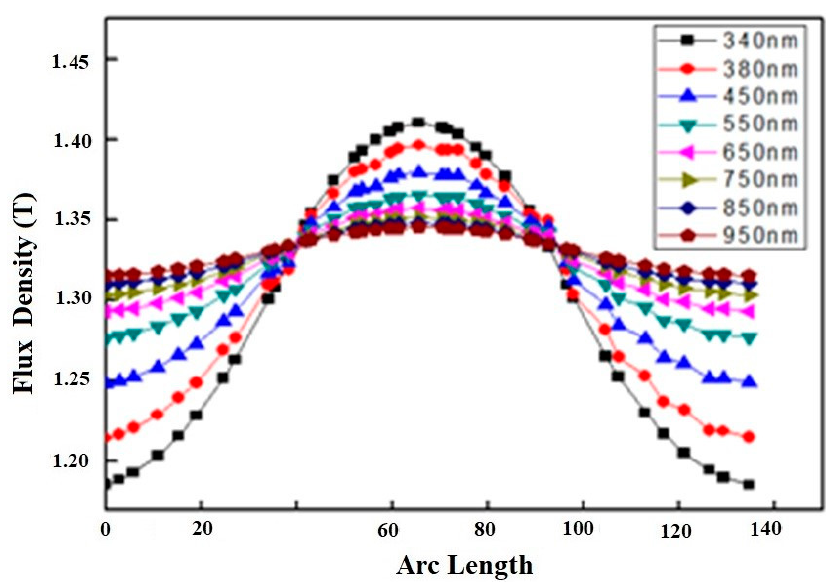
Figure 2. Flux density versus arc length showing propagation of plasmons at different wavelengths from 340 nm to 950 nm. The curves indicate variation of flux density as per the legend. The region 40–100 points to the nanowire placed with source whereas the regions 0–40 and 100–140 indicate boundaries of block.